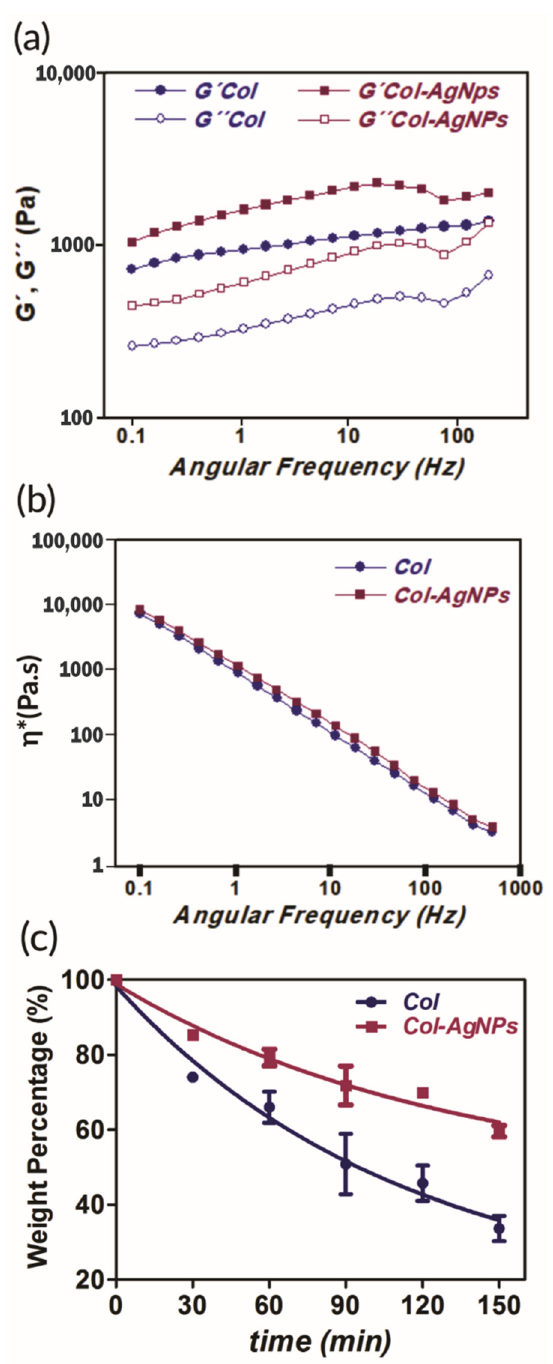
Figure 5. Mechanical properties ( a ), ( b ) and stability ( c ) of collagen scaffolds. ( a ) Dependence of the elastic (G´) and viscous modulus (G”) with frequency and ( b ) the viscosity ( ƞ *) of Col-AgNPs 67 mg/g (pink) and Col control (blue) at 37 °C. ( c ) Collagenase degradation of collagen matrices. Weight percentage is shown as a function of time for Col control (blue) and Col-AgNPs 67 mg/g (pink). Results are expressed as mean ± SD from triplicate experiments.